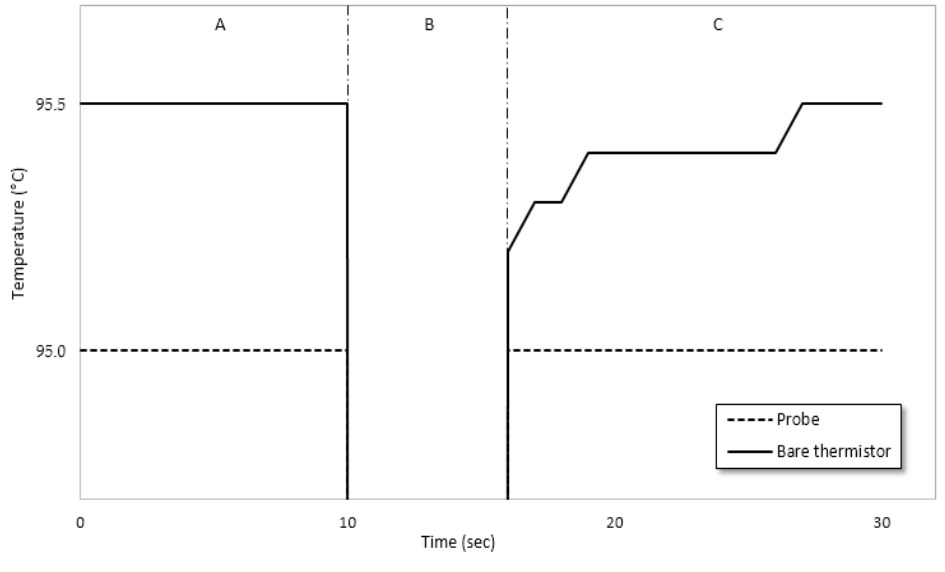
Figure 4. Self ‐ heating test at 95 °C. Figure 4. Self-heating test at 95 ◦